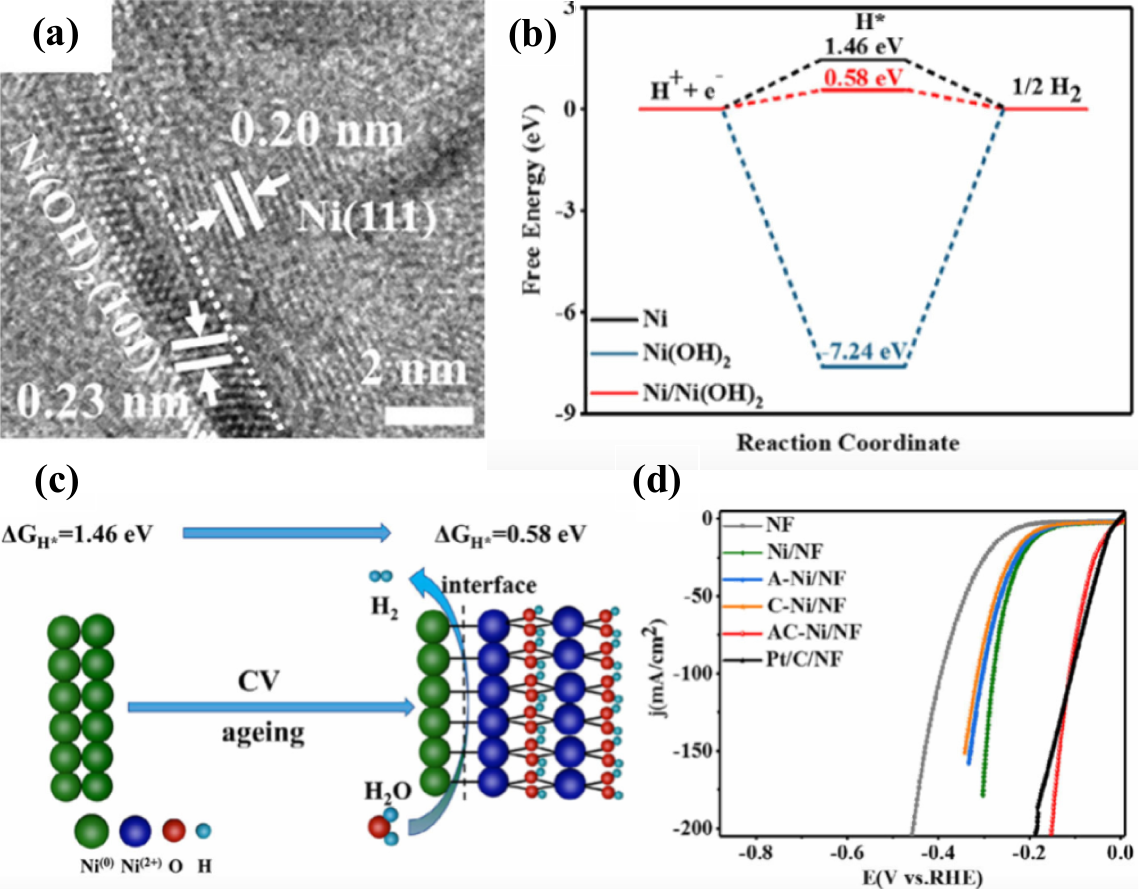
Figure 15. ( a ) HRTEM image of the AC-Ni/NF sample and ( b ) calculated free energy for atomic hydrogen adsorption on Ni, Ni(OH) 2 and Ni/Ni(OH) 2 . ( c ) Mechanism for the enhanced HER on the Ni/Ni(OH) 2 heterostructure. ( d ) Polarization curves of AC-Ni/NF and contrast samples at a scan rate of 2 mV s − 1 in 1M KOH. Reprinted with permission from Ref. [82].